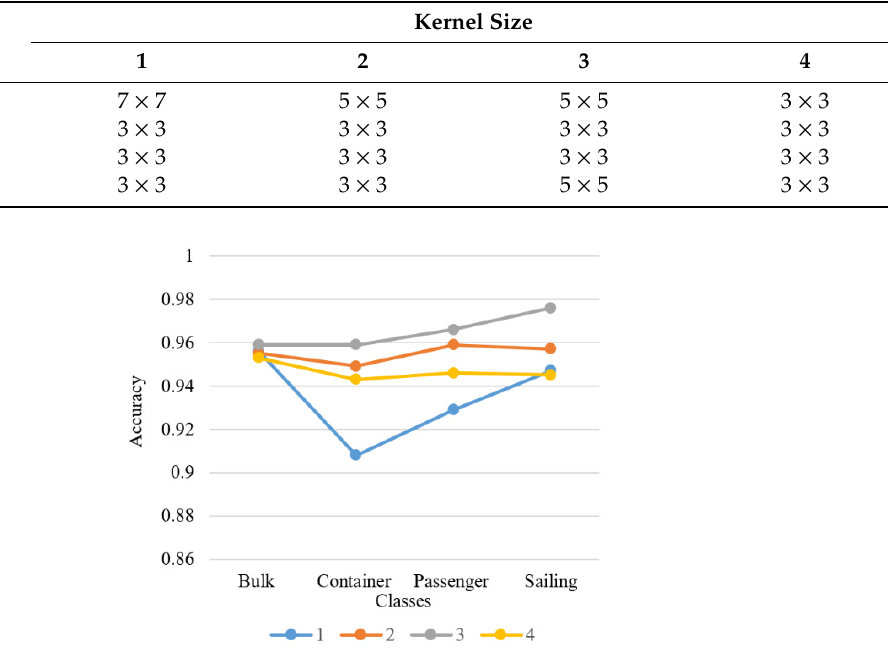
Figure 3. Classification accuracy (%) of each ship class corresponding to four cases listed in Table 1.